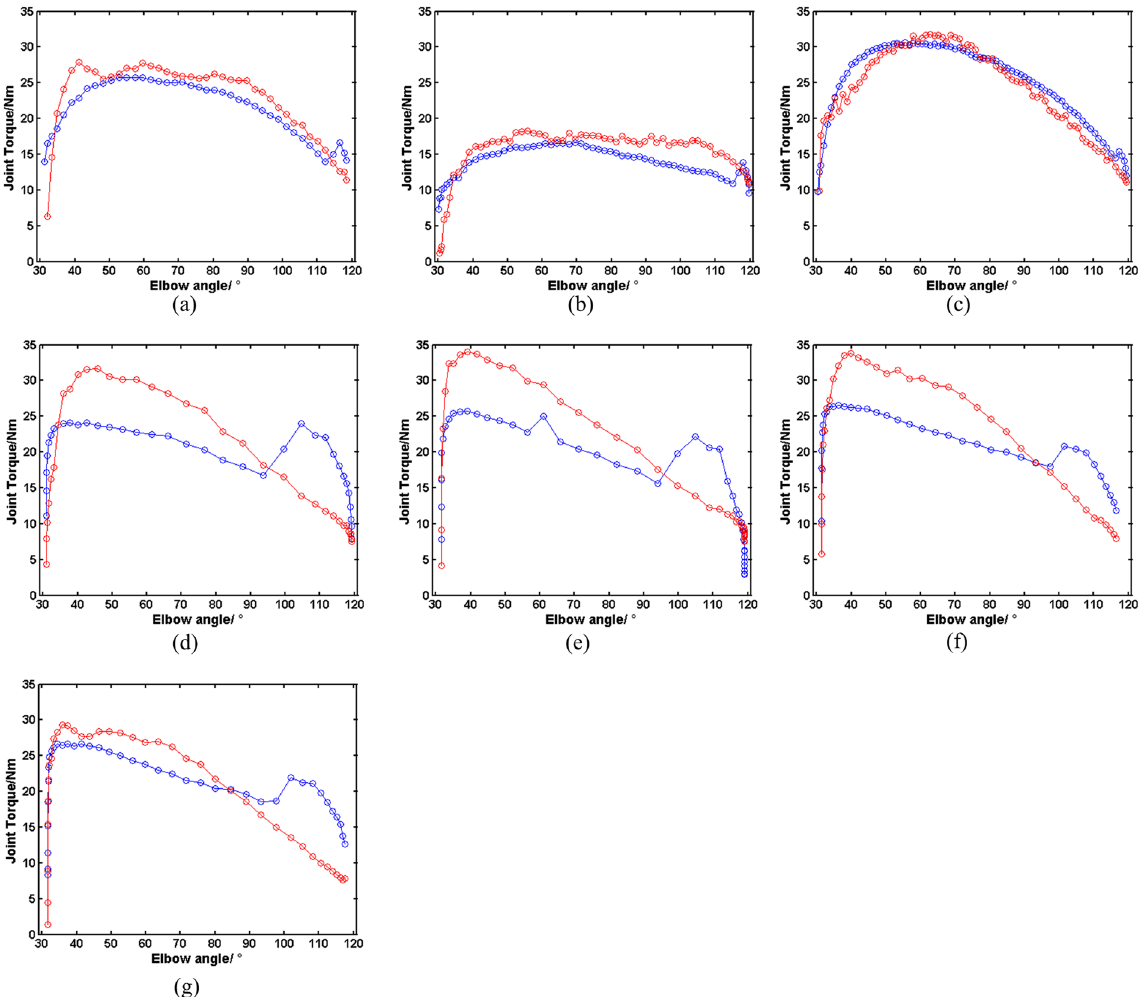
Figure 4. Comparison between the calculated (red) and measured torque (blue) (subject No. 1) in the 2 nd flexions in the 2 nd elbow kinetic flexion at: ( a ) 90°/s, ( b ) 120°/s and ( c ) 60°/s. and that in the elbow isotonic flexions: ( d ) the 1 st 30% T 120 flexion, ( e ) the 2 nd 30% T 120 flexion, ( f ) the 1 st 40% T 120 flexion, ( g ) the 2 nd 40% T 120